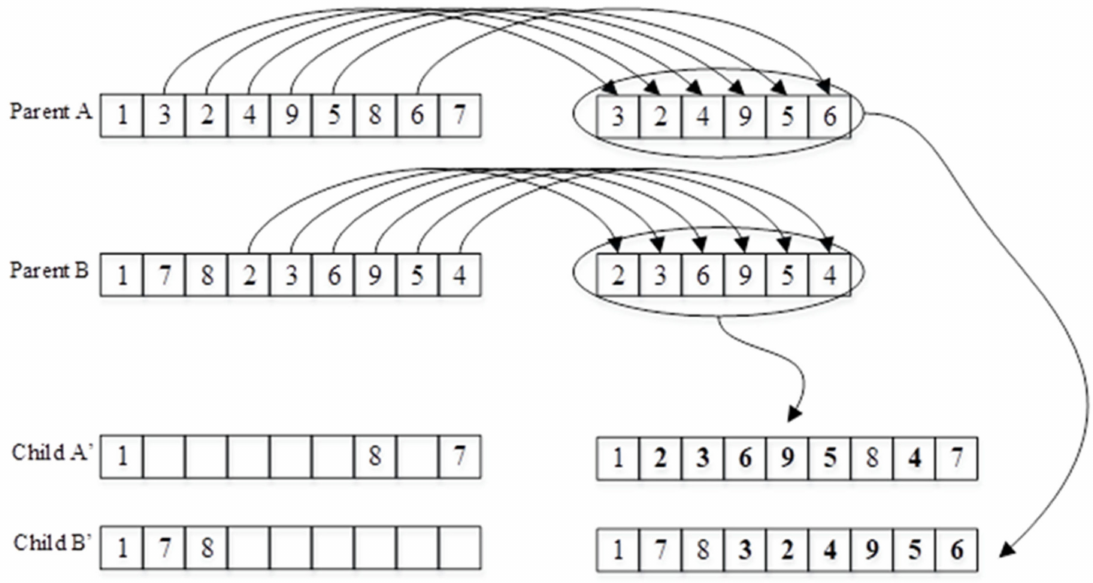
Figure 2. Crossover operator adapted to permutation coding in a 9 × 3 FSSP.